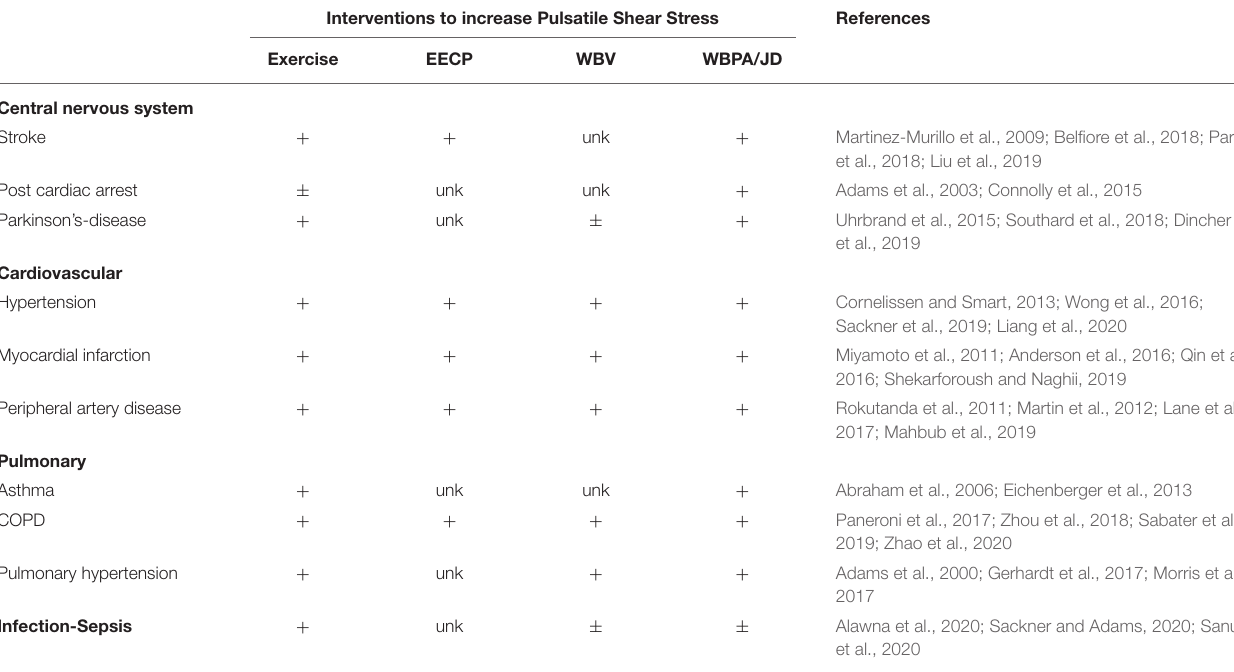
TABLE 1 | The effects of non-pharmacologic interventions which increase pulsatile shear stress on selected diseases. Interventions to increase Pulsatile Shear